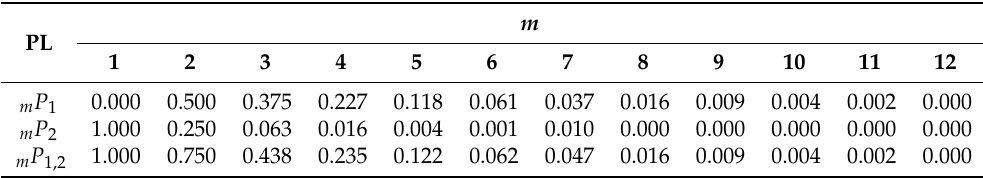
Table 7. Probabilities of loss (PL) of one gene ( m P 1 ), of two genes m P 2 , and of one or two genes ( m P 1,2 ) in the formation of the progeny of size m from a parent single cross of a Syn SC